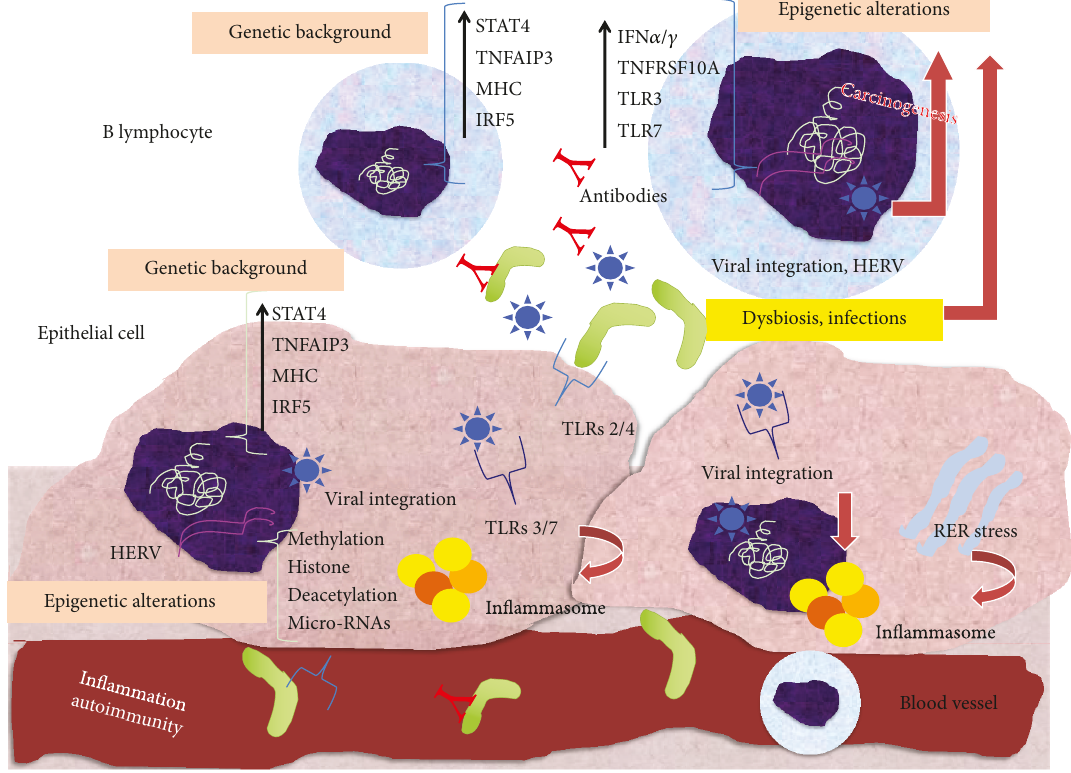
Figure 1: Pathogenesis of Sjögren ’ s syndrome and associated B cell lymphoma. On the basis of a favourable genetic background, represented by the hyperexpression of genes related to the in fl ammatory cascade (STAT4, TNFAIP3, MHC, and IRF5) shared by both B lymphocytes and salivary gland epithelial cells, infections or dysbiosis may modify the cell epigenetic machinery and consequently control gene expression, favouring in fl ammation, autoimmunity, and lymphomagenesis. Particularly, the epigenetic induction of the transcription of genes associated to microbial recognition (e.g., TLR3 and TLR7) and IFN-I signature, by means of aberrant methylation, histone deacetylation, and micro-RNA expression, may further promote the hyperactivation of B cells in response to foreign or endogenous epitopes, generated by bacteria, viruses, and endogenous retroelements. In addition, RER stress and integrated retroelements may favour the activation of in fl ammasomes and cause cell DNA rearrangements, which represent crucial steps for chronic B cell activation and transformation. These steps fi nally converge to the hyperproduction of autoantibodies cross-reacting with antigens locally or systemically, in fl ammation and destruction of glandular tissues, and B cell transformation into malignant clones. STAT4: signal transducer and activator of transcription 4; TNFAIP3: tumor necrosis factor-alpha-induced protein 3; MHC: major histocompatibility complex; IRF5: interferon-regulatory factor 5; IFN: interferon; TNFRSF10: tumor necrosis factor receptor superfamily member 10A; TLR: Toll-like receptors; HERV: human endogen retroviruses; RER: rough endoplasmic